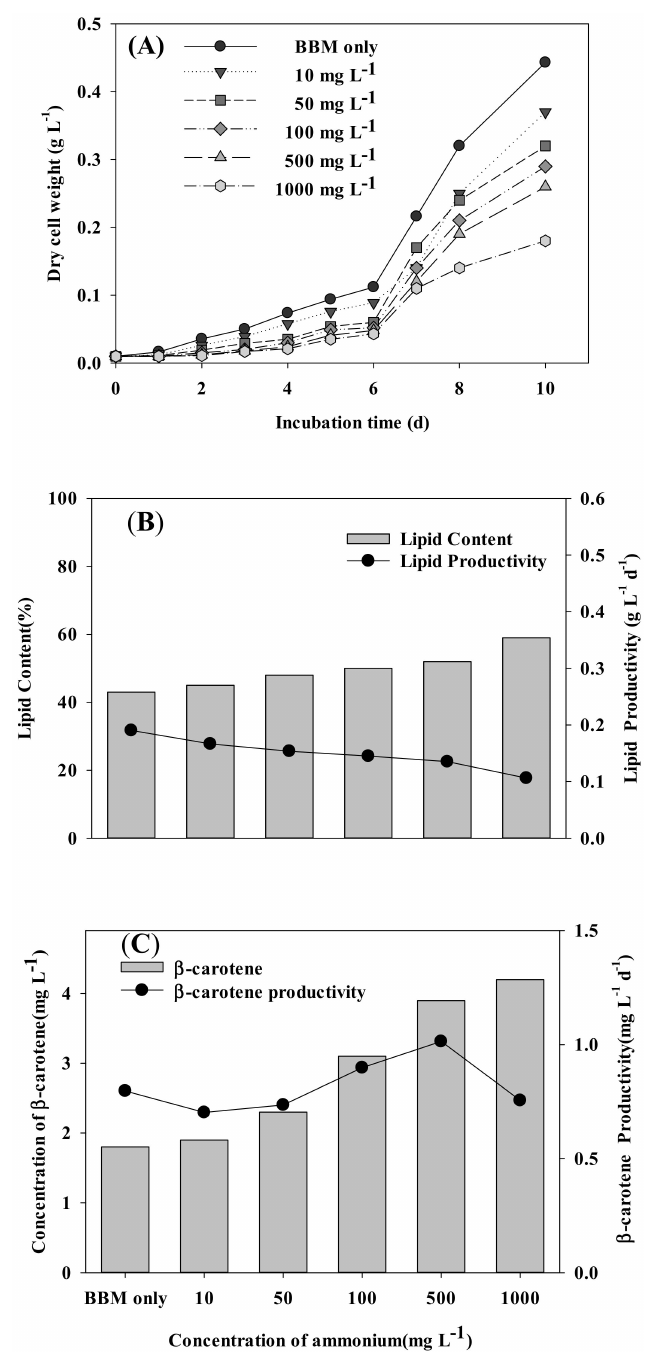
Figure 3. The e ff ect of ammonium the growth ( A ), lipid ( B ) and ß-carotene ( C ) of Uronema sp. KGE 3 cultivated in Bold’s Basal Medium